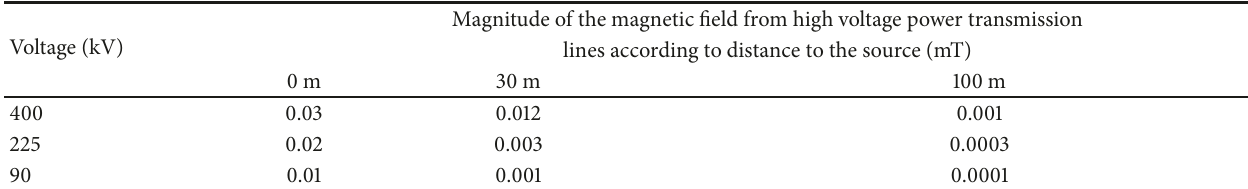
Table 5: Magnetic field from high voltage power transmission lines [9].